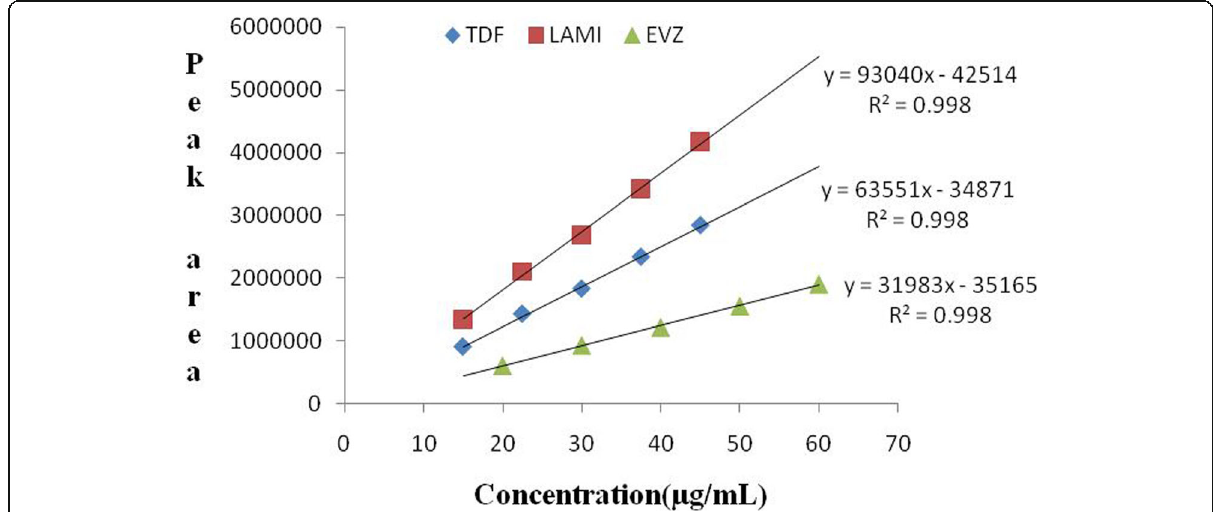
Fig. 3 Linearity curve of LAM, EVZ, and TDF